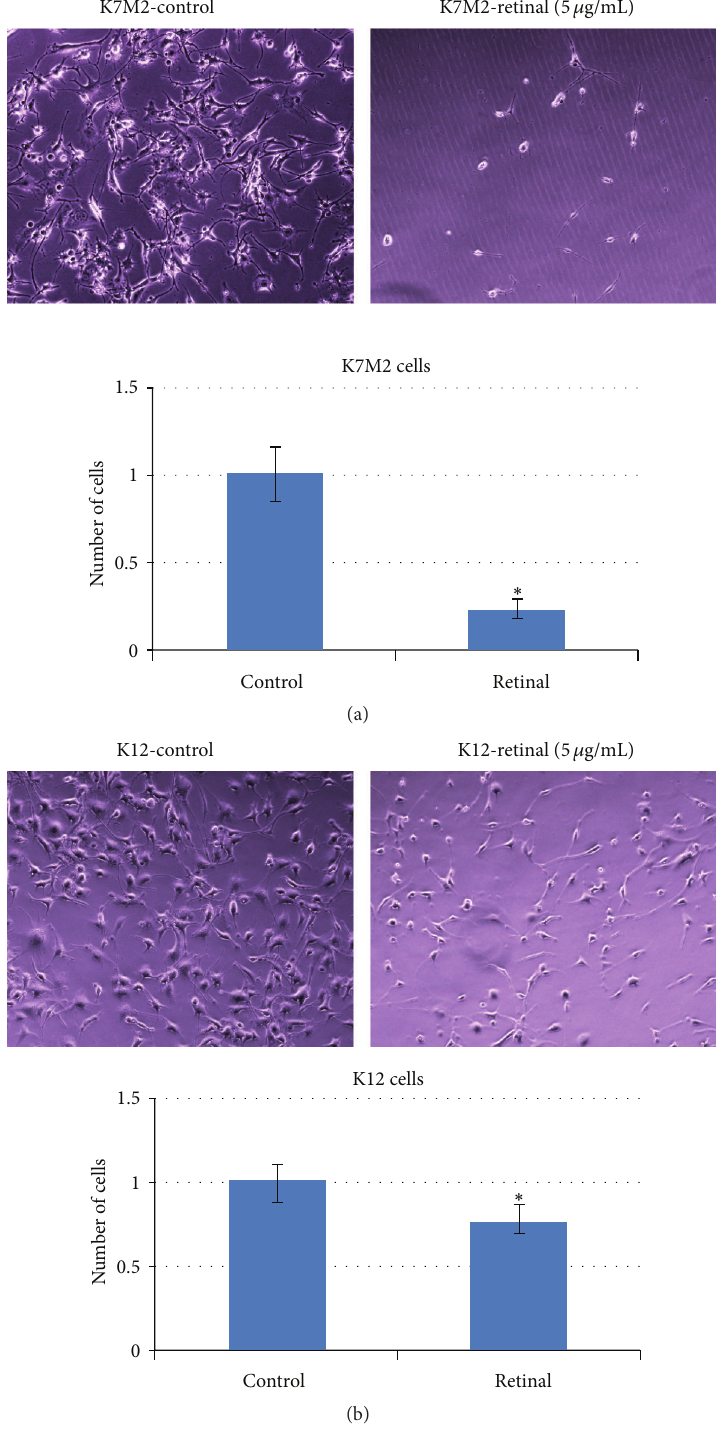
Figure 1: Retinal treatment of K7M2 cells decreased cell proliferation or survival. (a) and (b) The cell proliferation or survival capacity of K7M2 cells was more reduced with retinal treatment (5 𝜇 g/mL, 2 days), compared to K12